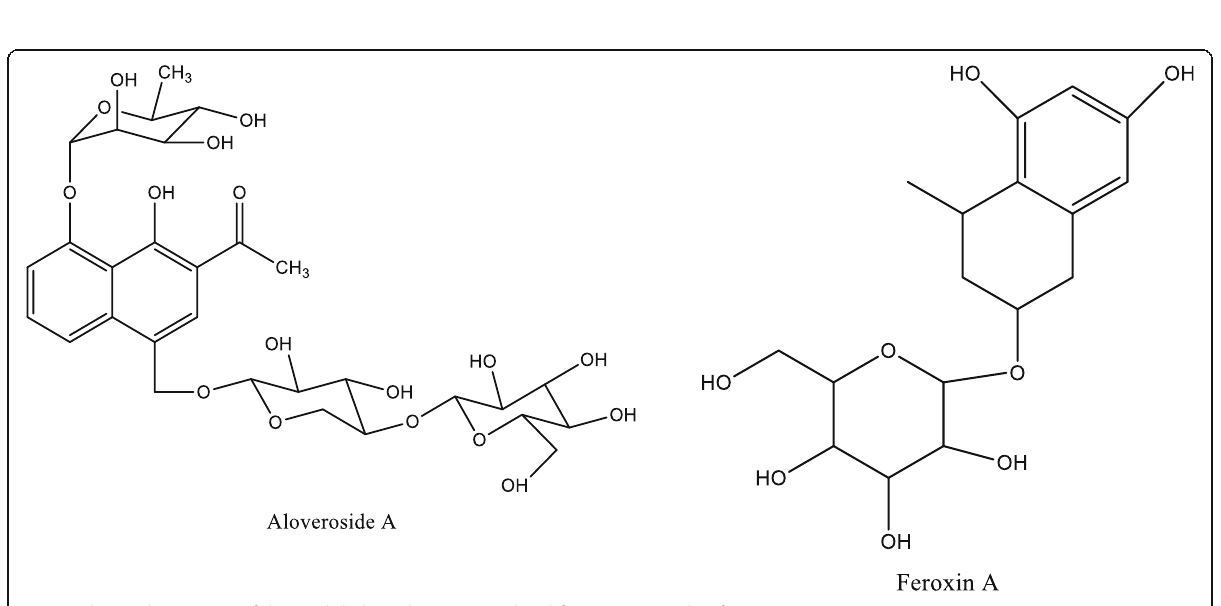
Fig. 6 Chemical structures of the naphthalene derivatives isolated from A. vera and A.